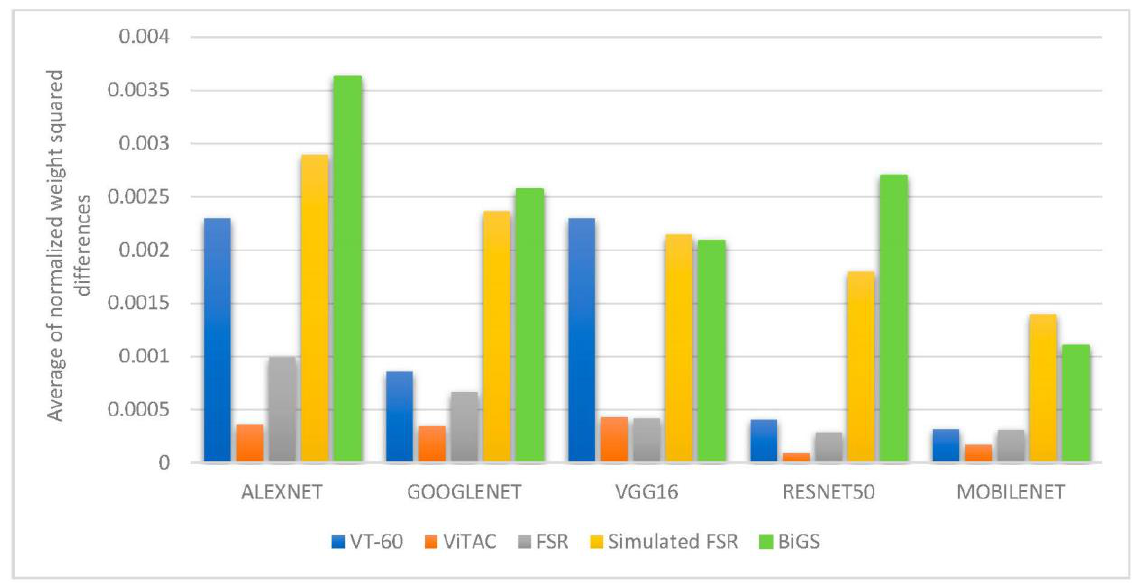
Figure 4. Average normalized weight differences between CNNs with frozen weights and CNNs with fine-tuned weights.